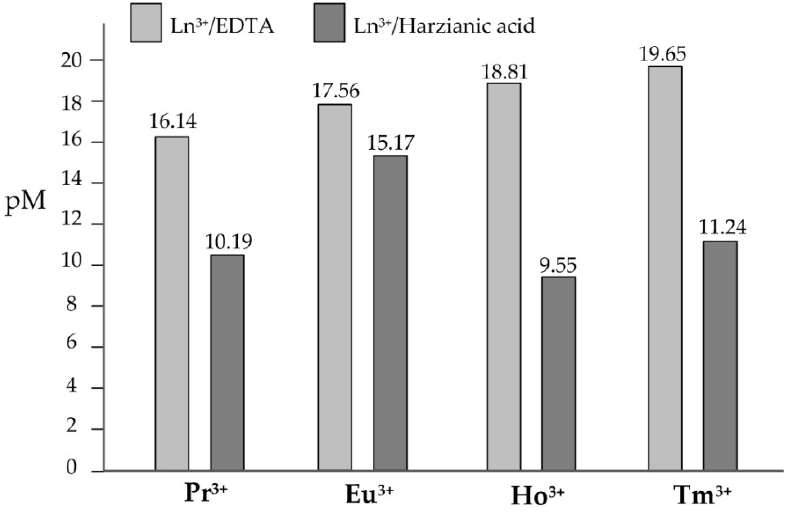
Figure 7. pM values calculated for Pr 3+ /harzianic acid, Eu 3+ /harzianic acid, Ho 3+ /harzianic acid, and Tm 3+ /harzianic acid systems using equilibrium constants determined in this paper in the 0.1 M NaClO 4 /(CH 3 OH + H 2 O 50/50 w / w ) solvent (dark gray bars). Light gray bars represent pM values calculated in water for Ln 3+ /EDTA systems, which are included to serve comparison purposes since EDTA is one of the most popular and efficient chelating agents for metal